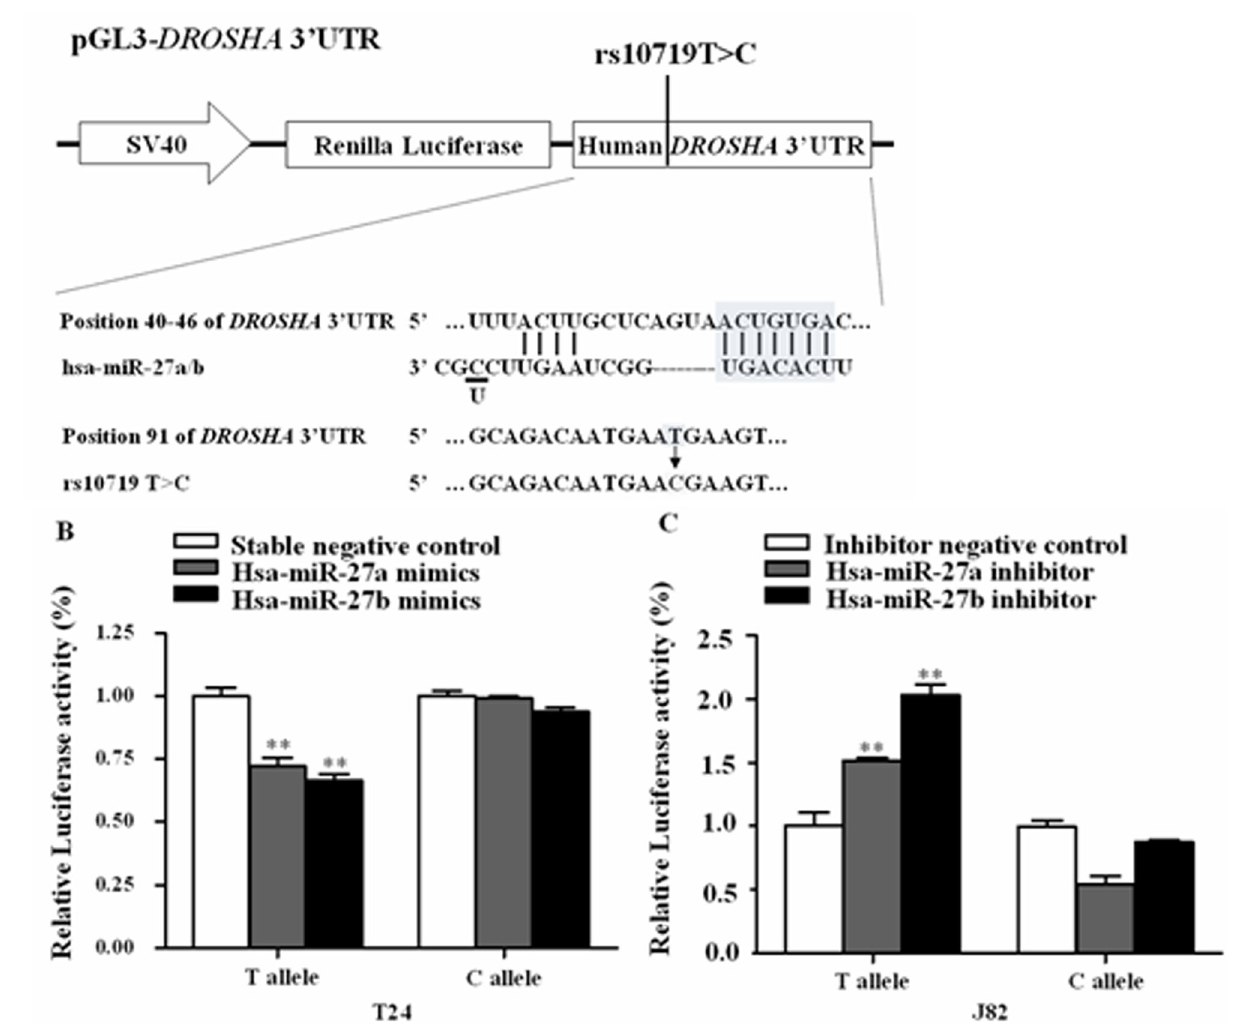
Figure 1. Characterization and functional analysis of the DROSHA 3’UTR. (A) DROSHA 3’UTR was predicted a binding site for hsa-miR-27a/b. The sequence of hsa-miR-27a and hsa-miR-27b only had one base difference (underlined). Scanning about ±100bp regions of the binding site, we only found that rs10719T>C was located in this region. Predict effect of allelic variation at rs10719 on hsa-miR-27a/b recognition and the construct of pGL3-DROSHA 3’UTR-T/C containing renilla luciferase gene and full- length 3’UTR of DROSHA gene with different alleles of rs10719 (arrow: T>C substitution). (B, C) Luciferase reporter assays to measure rs10719T or C allele difference with the presence or interference of hsa-miR-27a/b. In (B), T24 cells seeded on 24-well plates were transiently co-transfected with constructs and hsa-miR-27a/b mimics or stable negative control (NC). In (C), J82 cells seeded on 24-well plates were transiently co-transfected with constructs and hsa-miR-27a/b inhibitors or inhibitor NC. Results are shown as relative luciferase activity versus NC. Data were from three independent transfection experiments. doi: